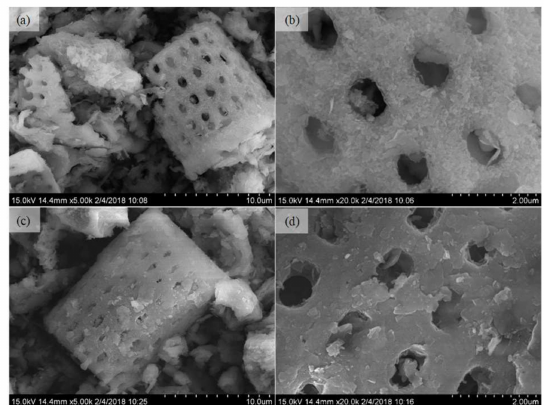
Figure 1. N 2 adsorption-desorption isotherms of diatomite (DIA) ( a ) Fe-Ce / DIA ( b ); inset: The pore size distribution.